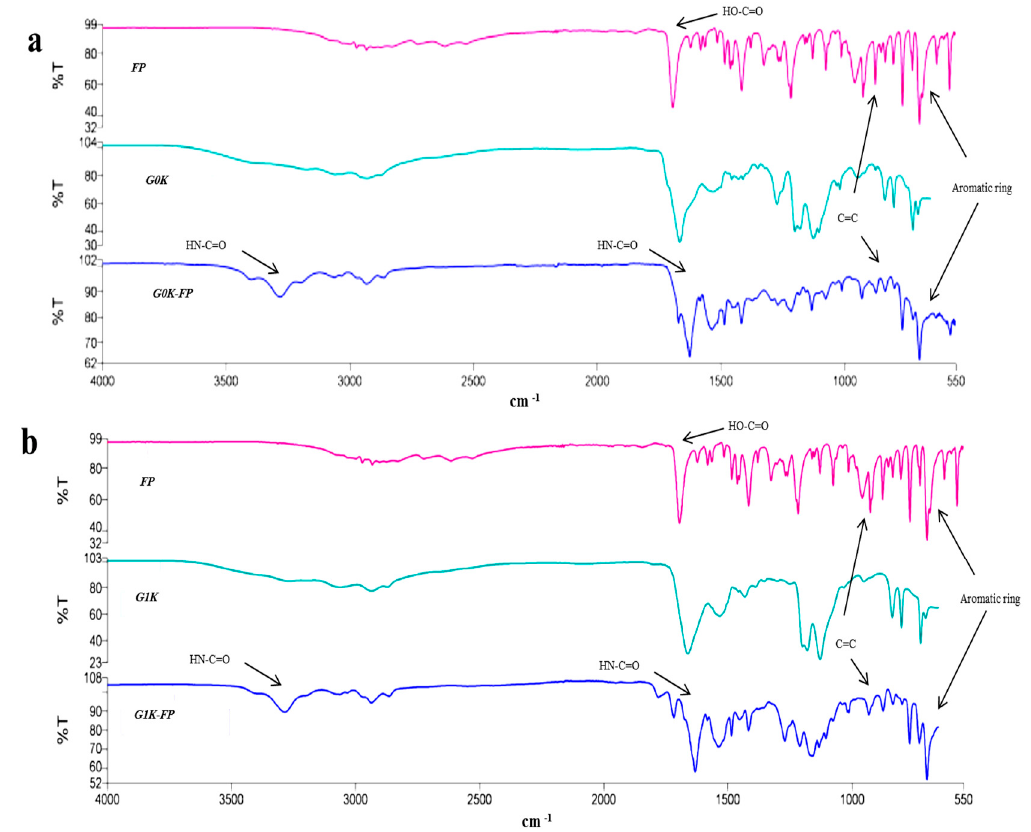
Figure 2. Fourier-transform infrared spectroscopy (FTIR) spectra of ( a ) FP alone, G0K and G0K-FP, ( b ) FP alone, G1K and G1K-FP. The spectra show shifting of peaks due to formation of peptide linkages at 3200 and 1646 cm − 1 . FP spectrum shows a strong carbonyl band seen at 1700 cm − 1 , related to its COOH functional group that disappeared in the G0K-FP and G0K-FP spectra due to amide linkage formation. Appearance of peaks at 782 cm − 1 corresponded to the aromatic ring of FP with its C=C peak at 910 cm − 1 in the G0K-FP and G1K-FP spectra confirms the FP attachment to the dendrons.